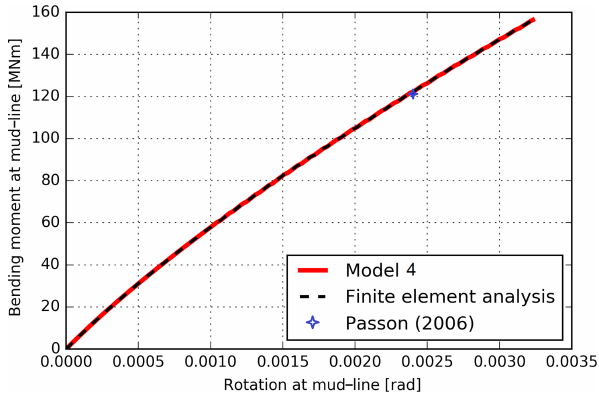
Figure 14. Computed moment–rotation curve at mud-line from fi- nite element analyses and from the calibrated Model 4. The repre- sentative moment and rotation at mud-line used in the calibration from Passon (2006) are included as a